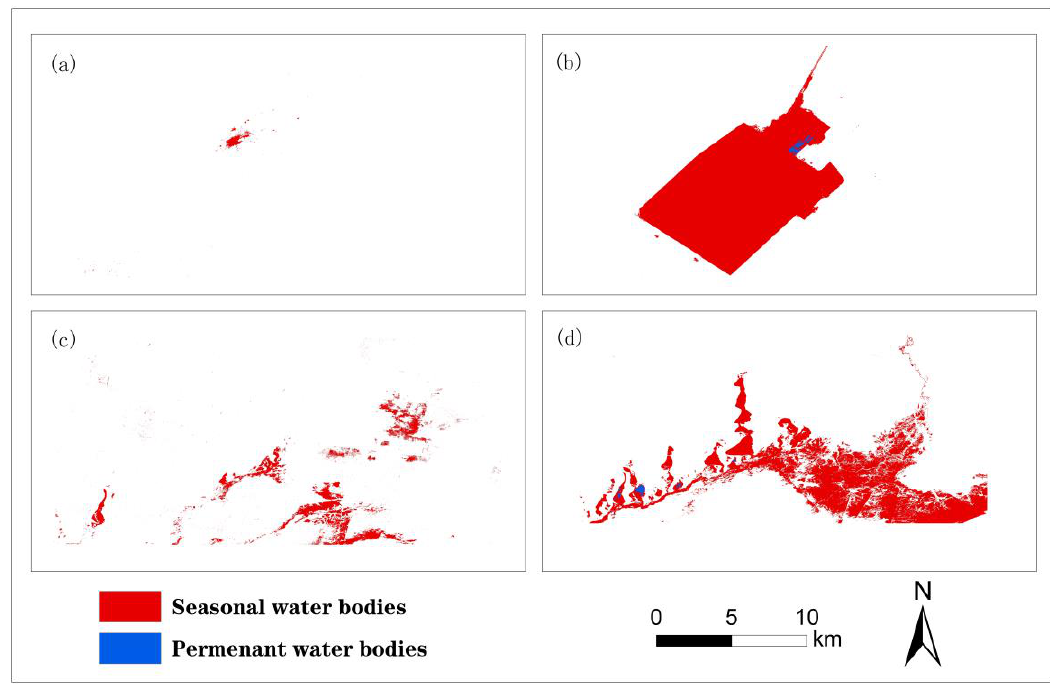
Figure 14. Open-surface water bodies: ( a ) before (1986–2000) and ( b ) after (2001–2019) the Lop Nor Potash Plant; and ( c ) before (1986–2000) and ( d ) after (2001–2019) the ecological water